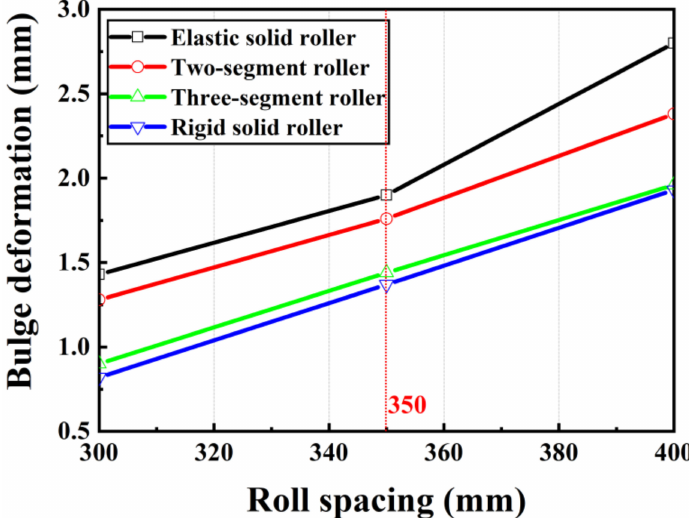
Figure 10. The bulge deformation on the wide side with different roller spacings. Table 6. Bulge deformation on the wide side with different roller spacings. Roller Spacing